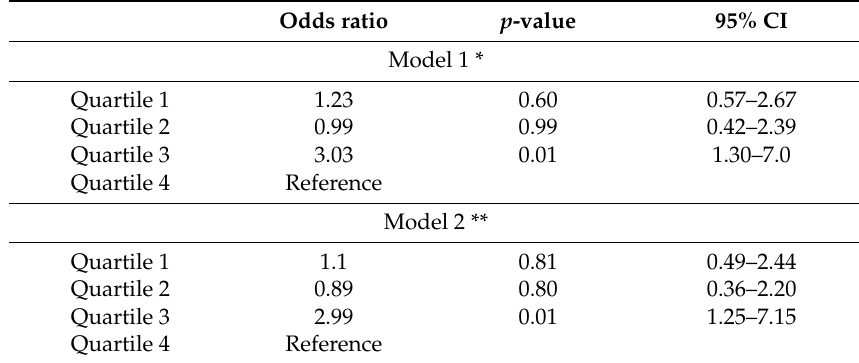
Figure 3. Birth weight according to family support network quartile. Table 3. Associations between small for gestational age newborns and family support network (in quartiles) provided to pregnant adolescents.